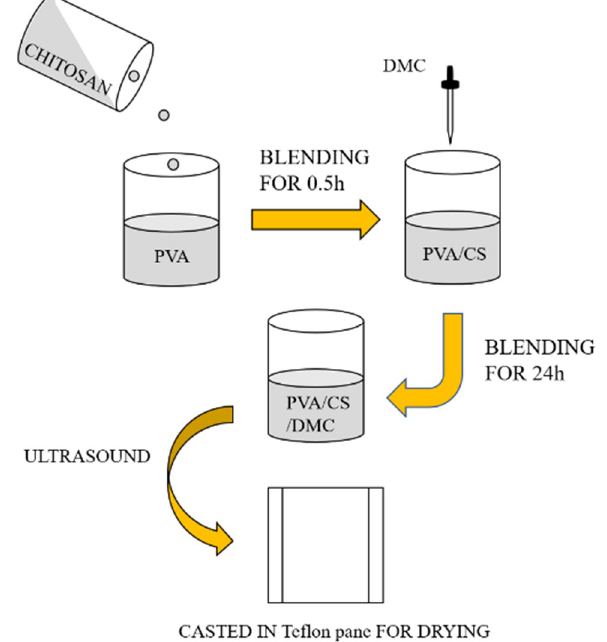
Figure 1. Schematic illustration of the poly (vinyl alcohol) / chitosan / 2-[(methacryloyloxy) ethyl] trimethylammonium chloride (PVA / CS / DMC) blend films’ fabrication process. Table 1. Sample codes and composition for the poly (vinyl alcohol) / chitosan / 2‐[(methacryloyloxy)